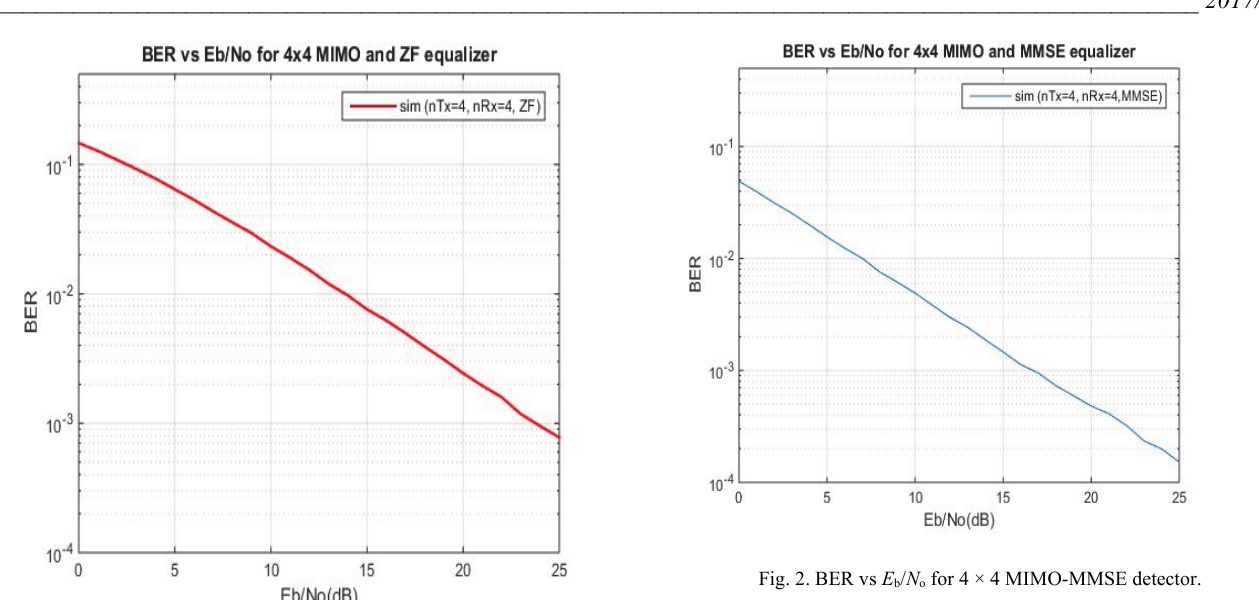
Fig. 2. BER vs E b / N o for 4 × 4 MIMO-MMSE